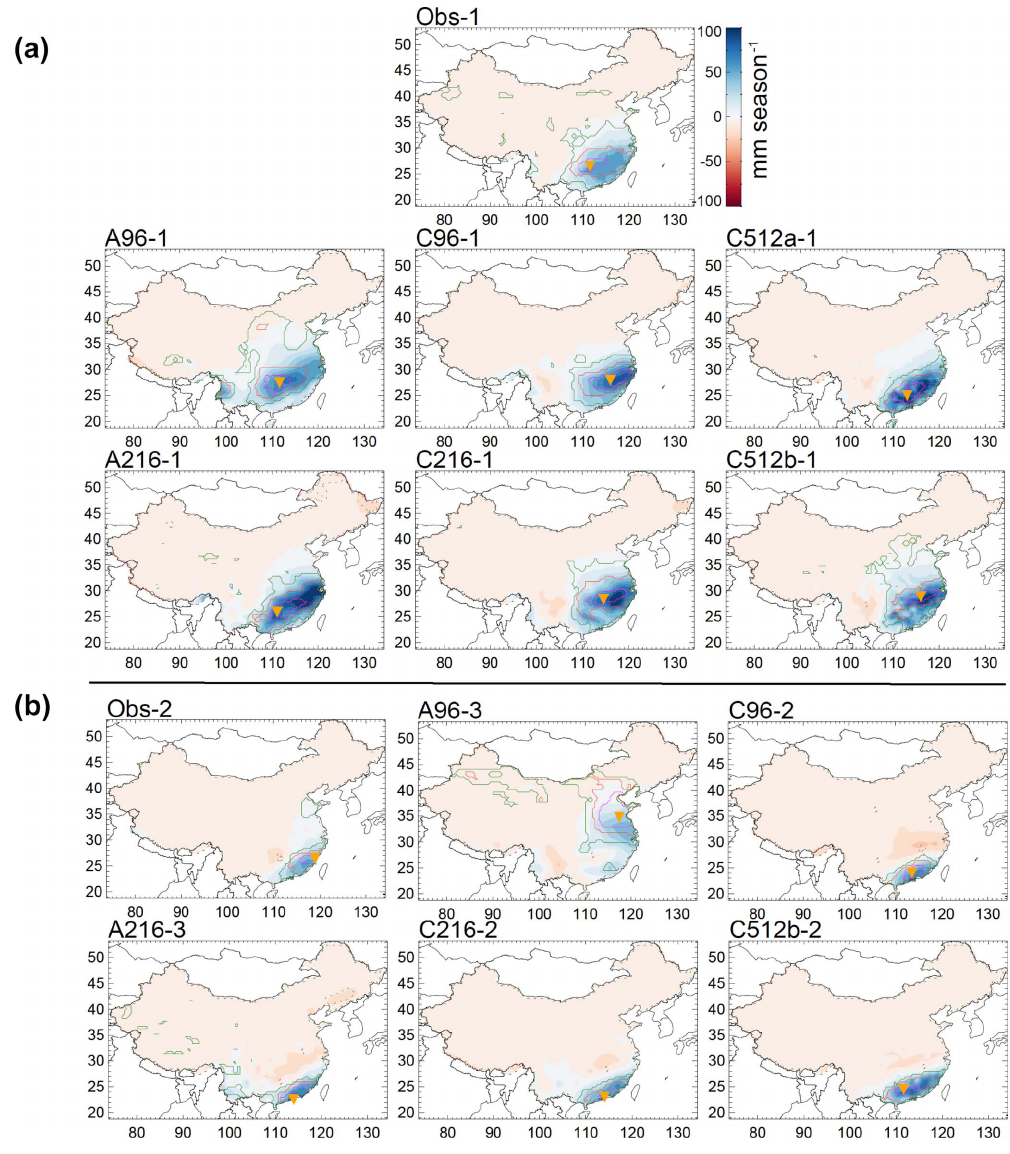
Figure 6. Shading shows regressions of DJF precipitation against observed or simulated EOT time series. Also shown are positive (solid lines) and negative (dashed lines) correlations of the full (leading-order) or residual (higher-order) precipitation-anomaly time series with the EOT base point exceeding 0.8 (magenta), 0.6 (orange) and 0.4 (green). The EOT base point is marked by the orange inverted triangle. Panel (a) shows patterns that have a linear correlation coefficient exceeding 0.38 with the first observed pattern and (b) with the second observed pattern. The number next to the simulation name above each panel indicates the order of the simulated EOT